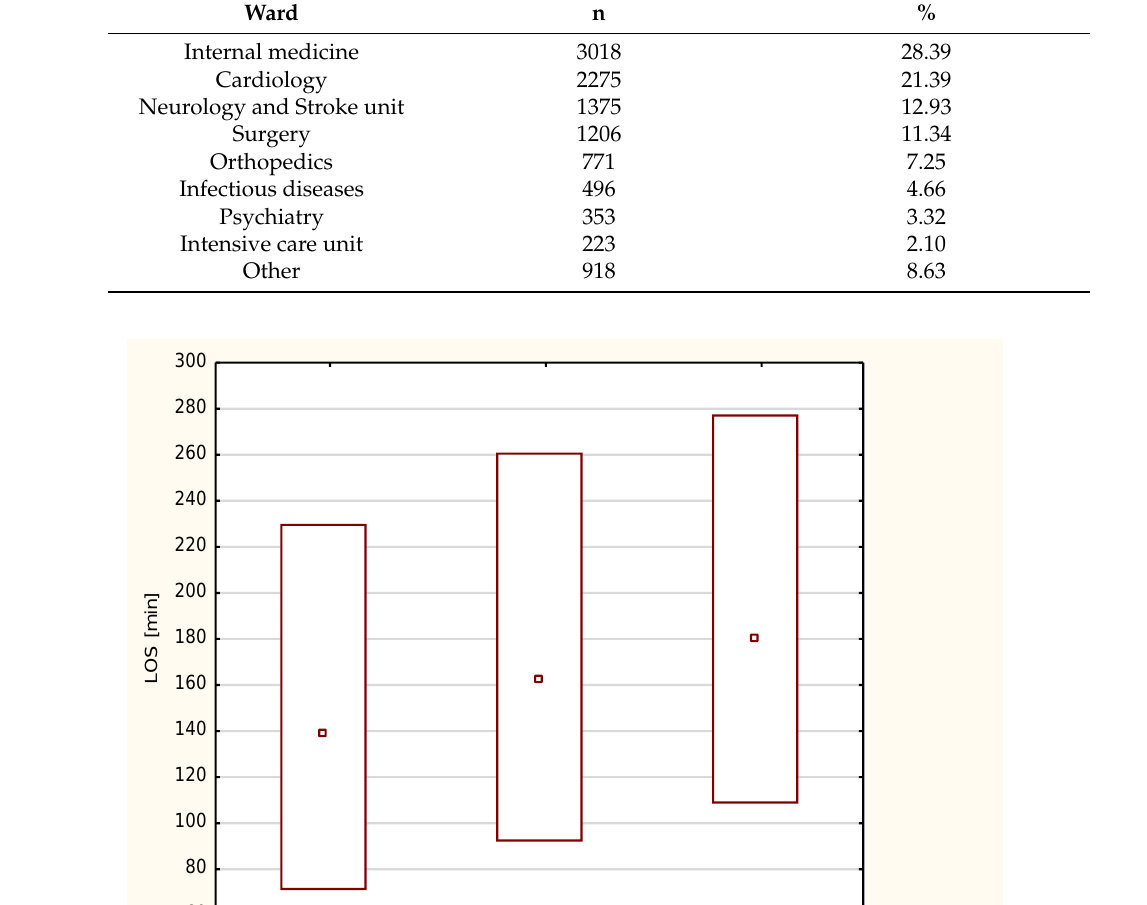
Table 2. The detailed number of resources used for geriatric patients.